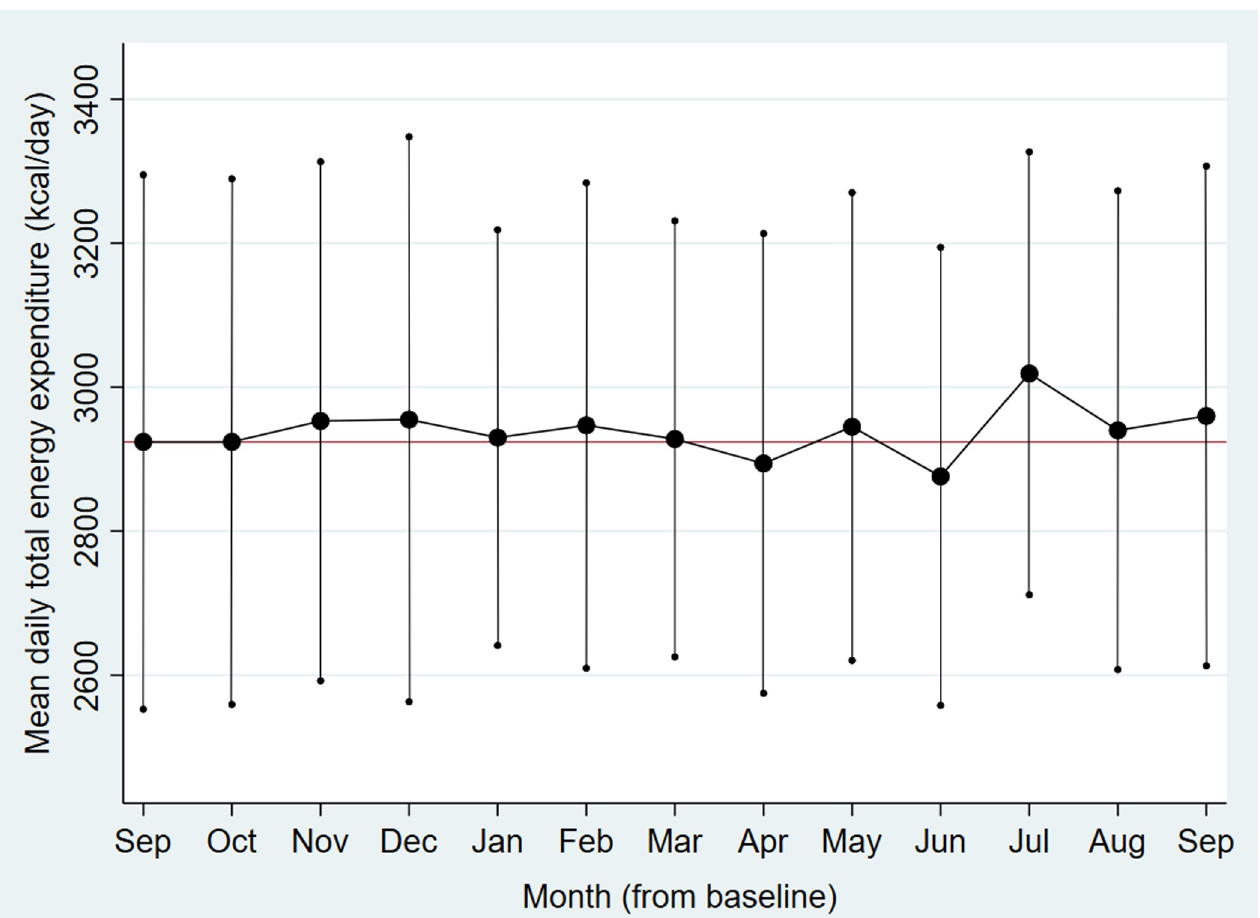
Fig 4. Monthly mean daily total energy expenditure from baseline to end-of-follow-up. The RESTART pilot study 2017–18.